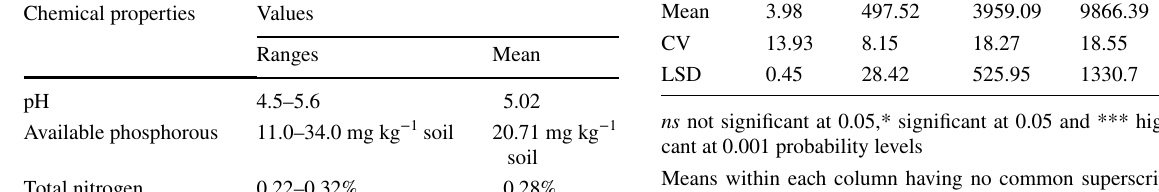
Table 3 Soil chemical analysis results for the experimental sites prior to application of organic and mineral amendments Chemical properties